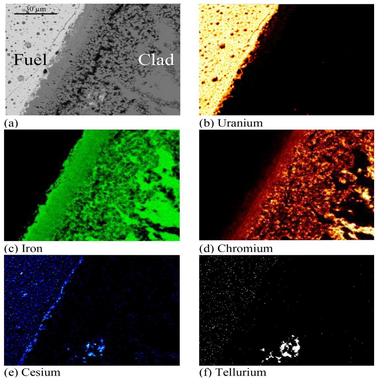
(a) BSE image of the FCCI region. EDS qualitative maps of (b) U, (c) Fe, (d) Cr, (e) Cs, (f) Te.